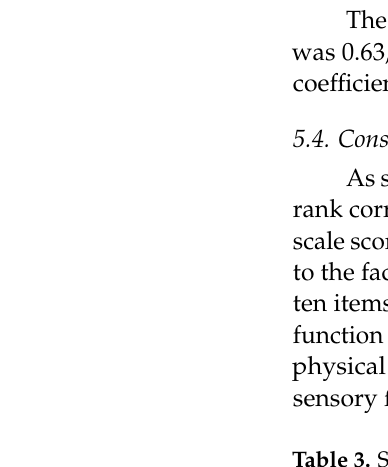
Table 3. Spearman’s correlation between items and total score and the factor analysis of the CFSS-10 (sample